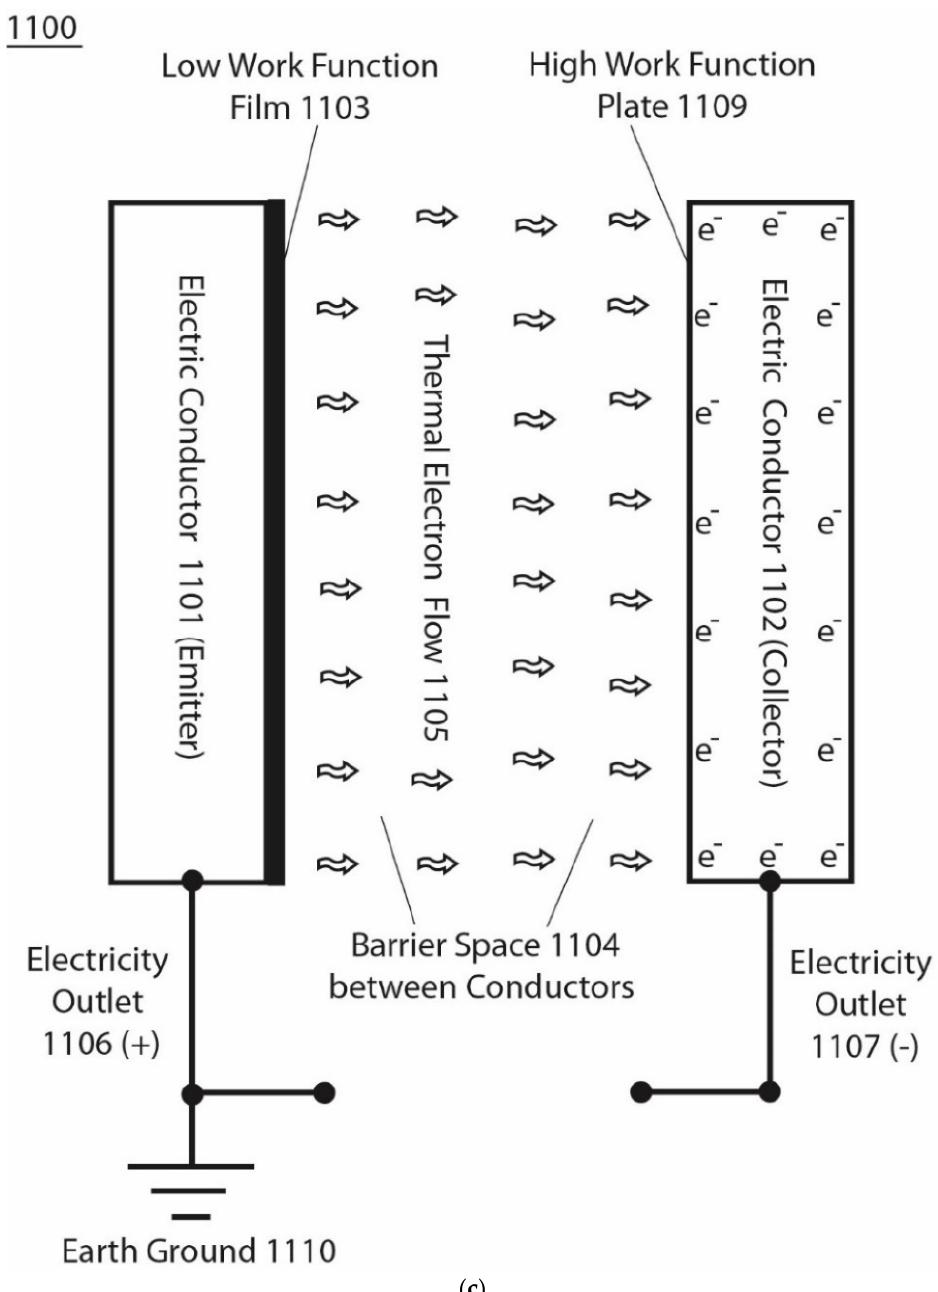
Figure 2. ( a ) presents a basic unit of an asymmetric electron-work-function-gated isothermal electricity generator system 1100 comprising “a barrier space such as a vacuum space (gap) that separates a pair of electric conductors: one of them has a low work function film to function as a thermal electron emitter and the other has a high work function plate surface to serve as an electron collector”. ( b ) illustrates certain characteristics in the asymmetric electron-work-function-gated isothermal electricity generation system 1100 such as the excess holes (positive charges) left at the emitter will also electrostatically spread to the surface, and likewise so do the excess electrons at the collector under the “open circuit” condition. ( c ) illustrates a preferred practice to ground the emitter with an Earth ground at the electricity outlet 1106 terminal of the asymmetric electron-work-function-gated isothermal electricity generation system 1100.